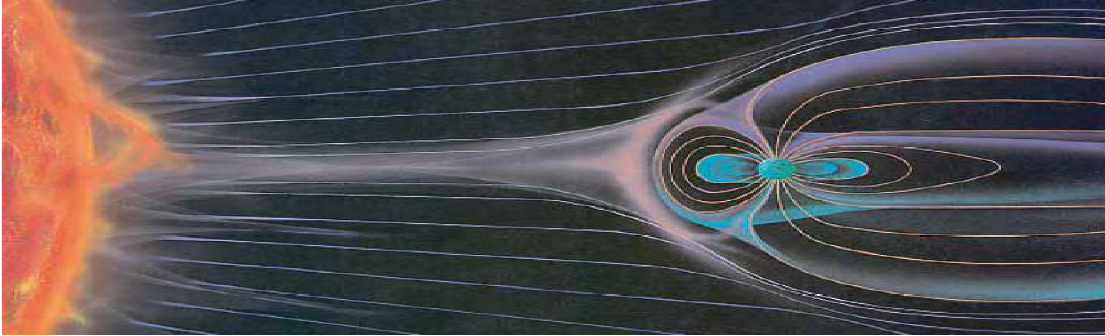
Figure 8. Schematic picture of “Sun wind” consisting of plasma fluxes erupted from the Sun’s surface and their interaction with Earth’s magnetic